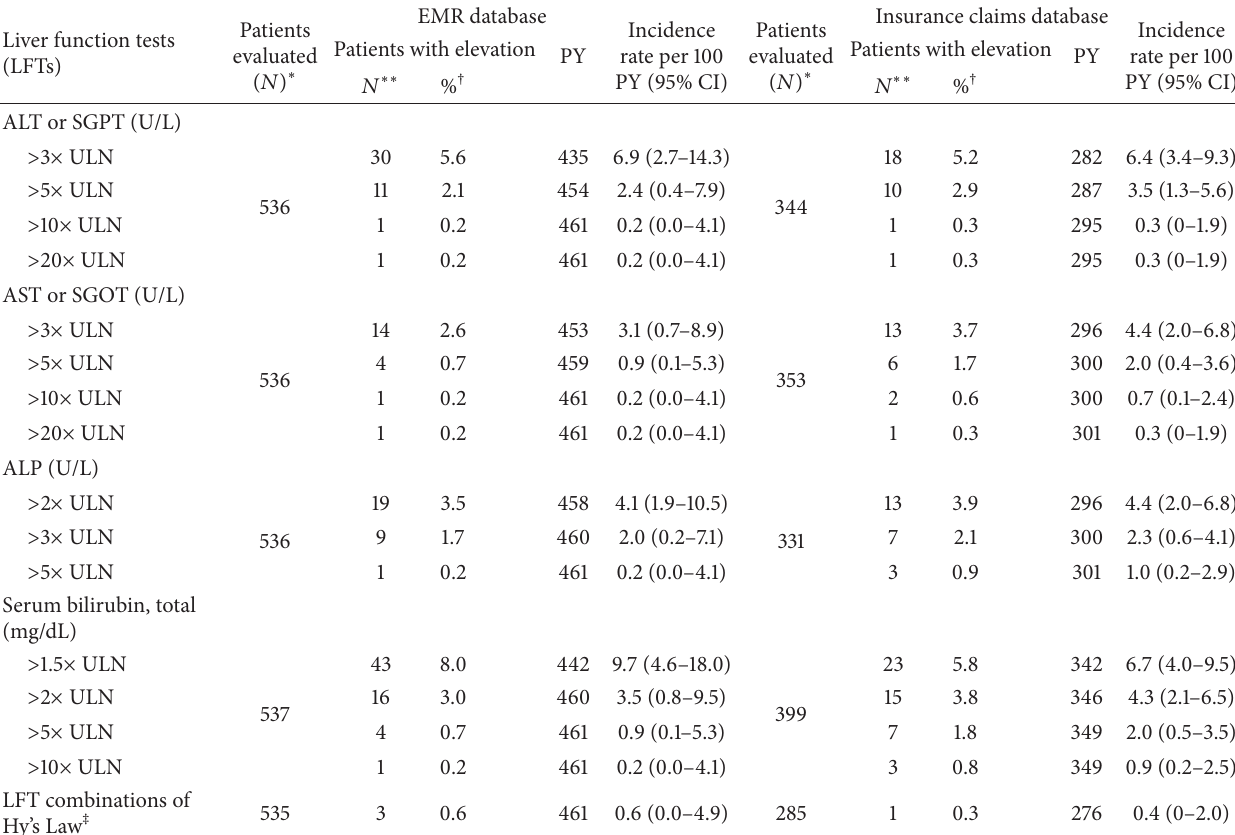
Table 4: Incidence of first occurrence of each degree of elevation for multiple liver function tests, TKI cohorts. Liver function